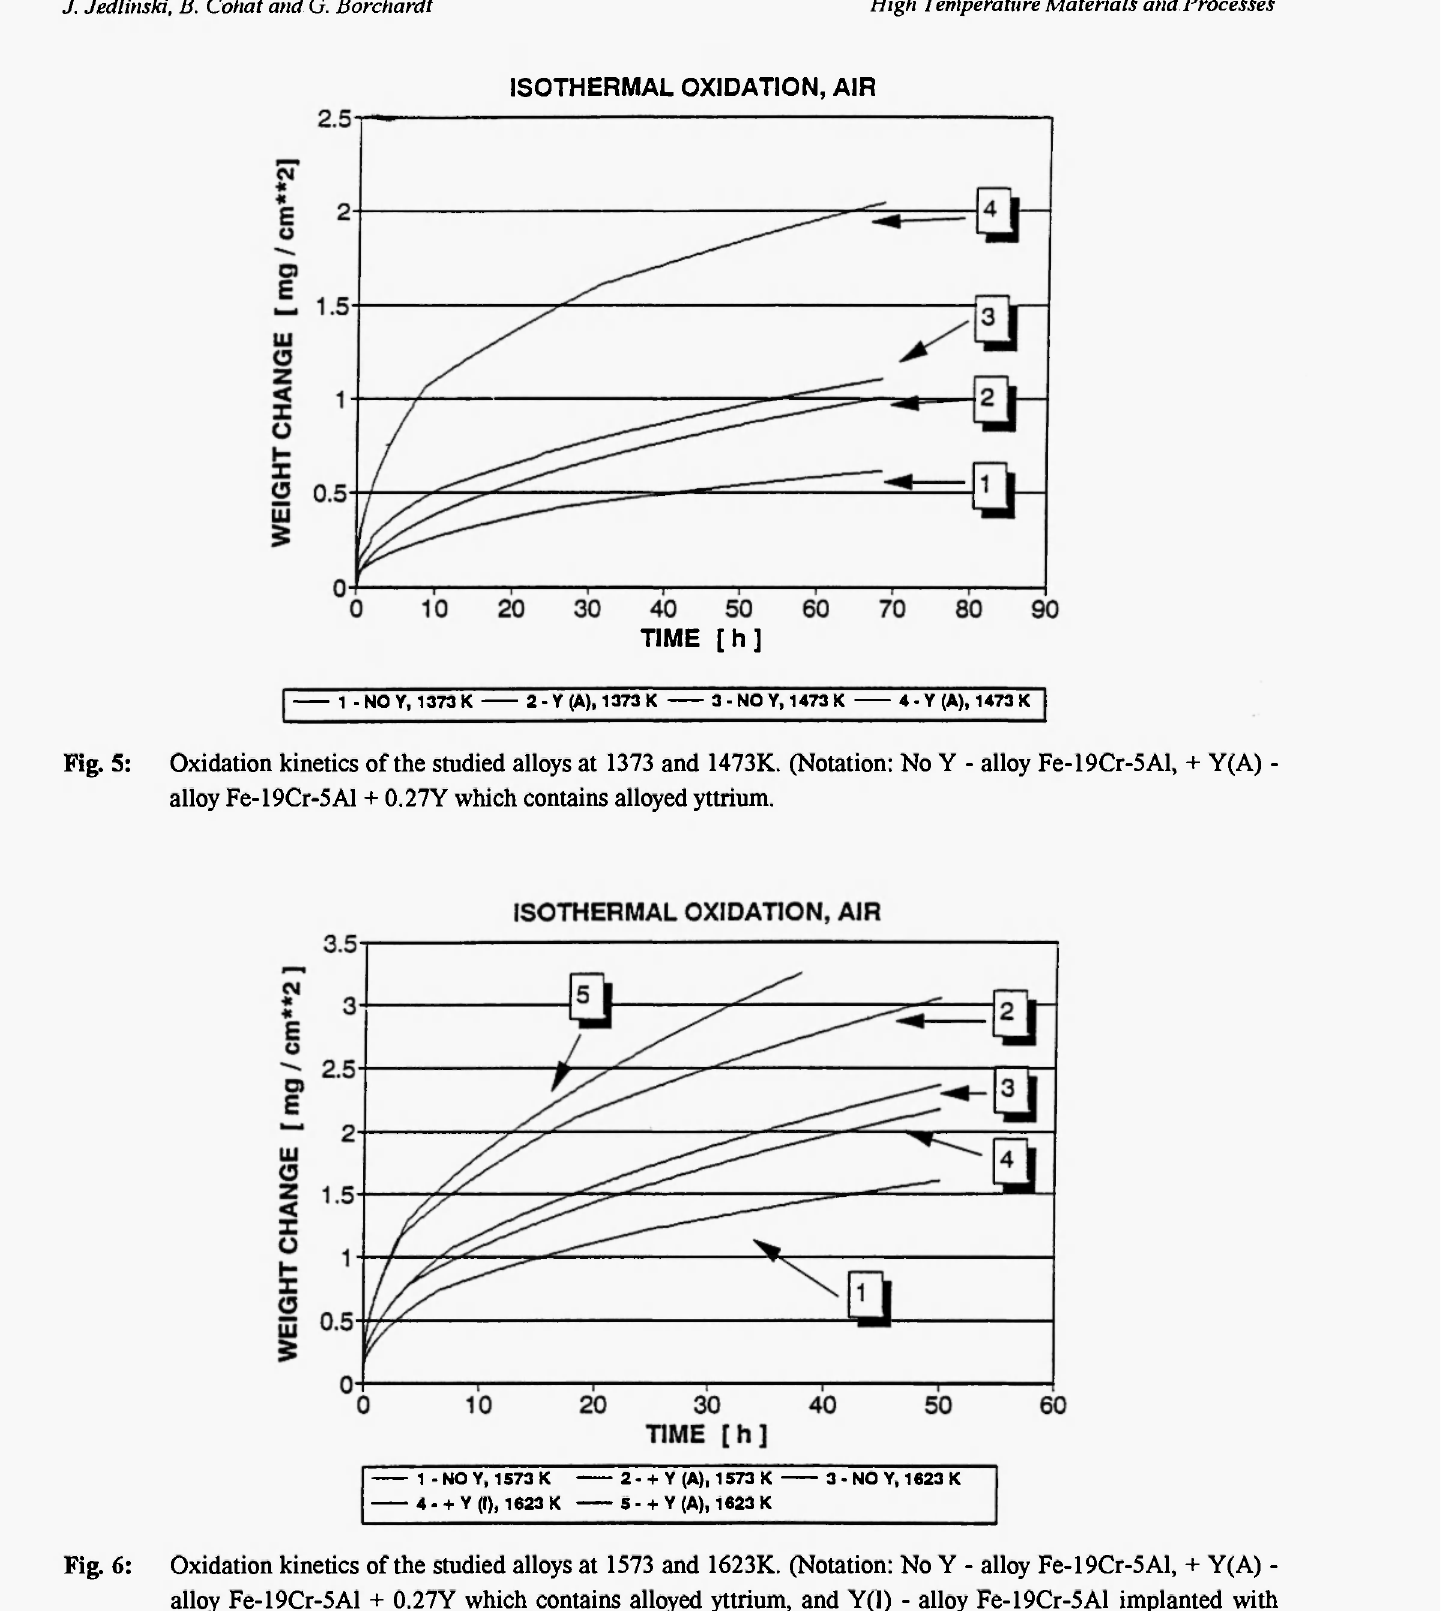
Fig. 6: Oxidation kinetics of the studied alloys at 1573 and 1623K. (Notation: No Y - alloy Fe-19Cr-5Al, + Y(A) - alloy Fe-19Cr-5Al + 0.27Y which contains alloyed yttrium, and Y(I) - alloy Fe-19Cr-5Al implanted with yttrium, using energy beam of 70 keV and fluence of 2xl0 16 Y + /cm 2 )